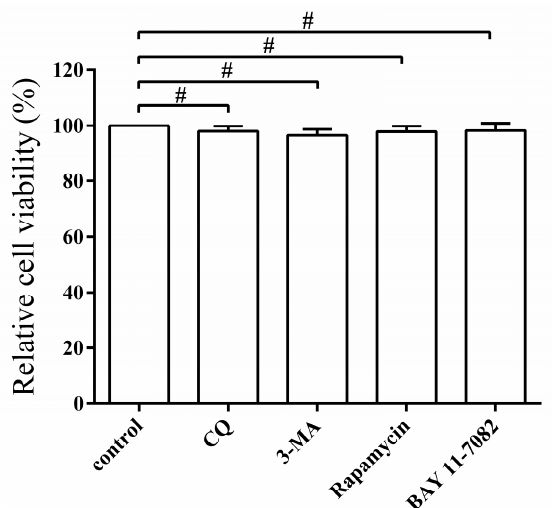
Figure 7. Pharmacological regulation of autophagy does not affect cell viability. The cell viability was determined by MTT assay after treatment with CQ (50 μ m), 3 ‐ MA (5 μ m), rapamycin (1 μ g/mL), and BAY 11 ‐ 7082 (10 μ m) for 48 h, respectively. The data represent the mean ± SEM of three independent experiments. ( t ‐ test, # p > 0.05).